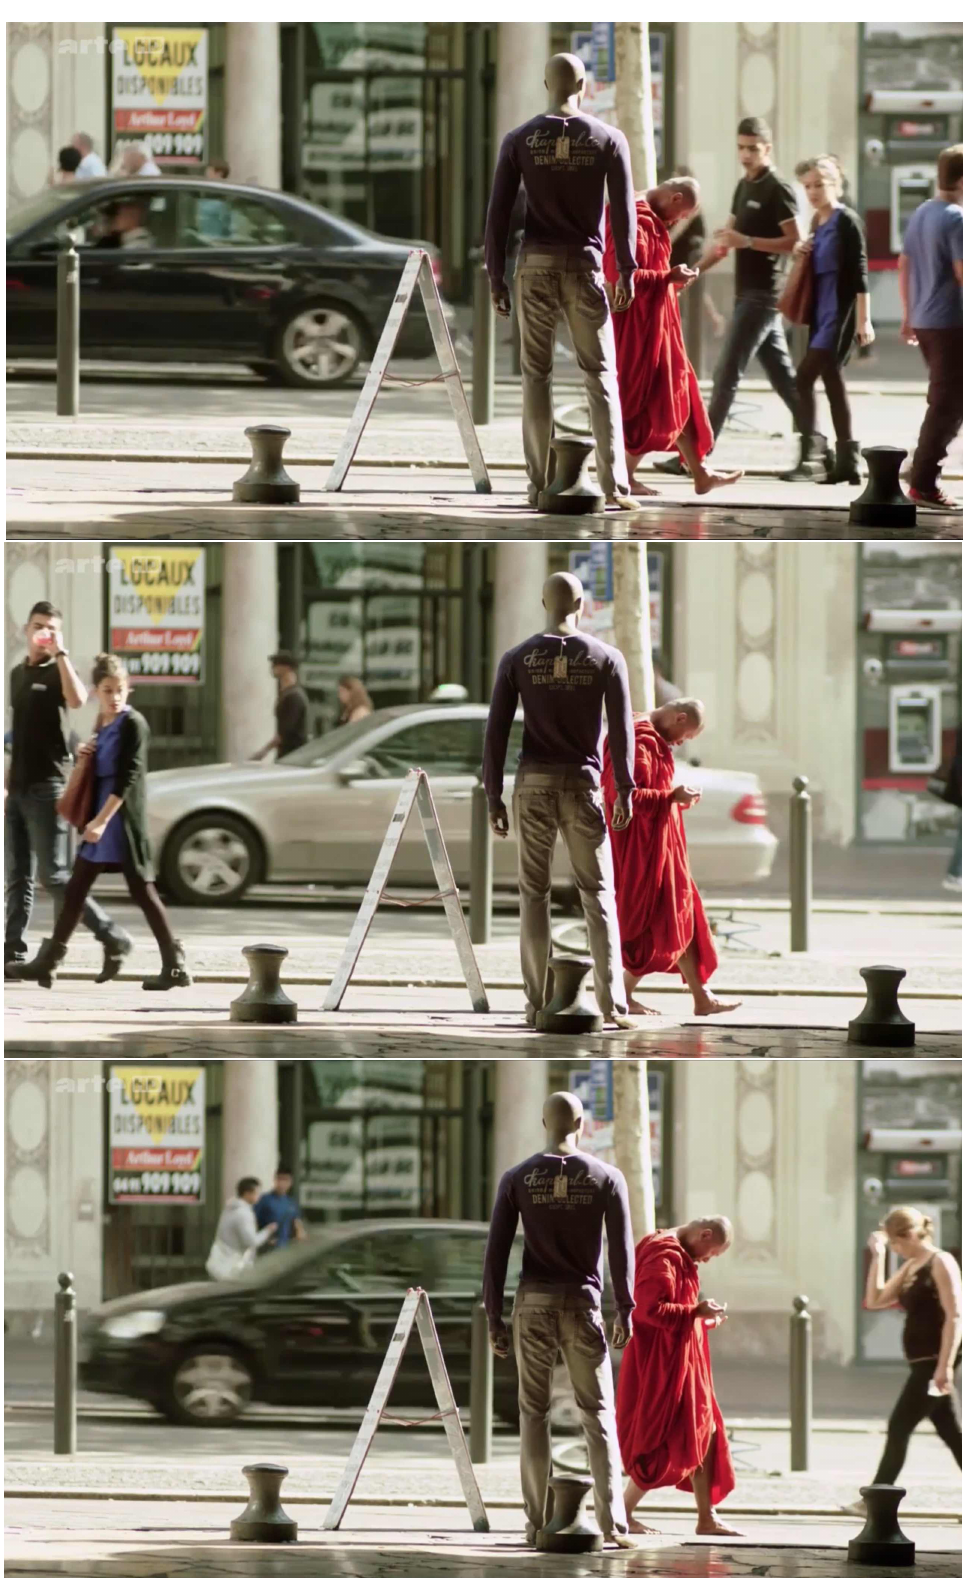
Figure 1: Journey to the West , Tsai Ming-Liang, Taiwan, 2014